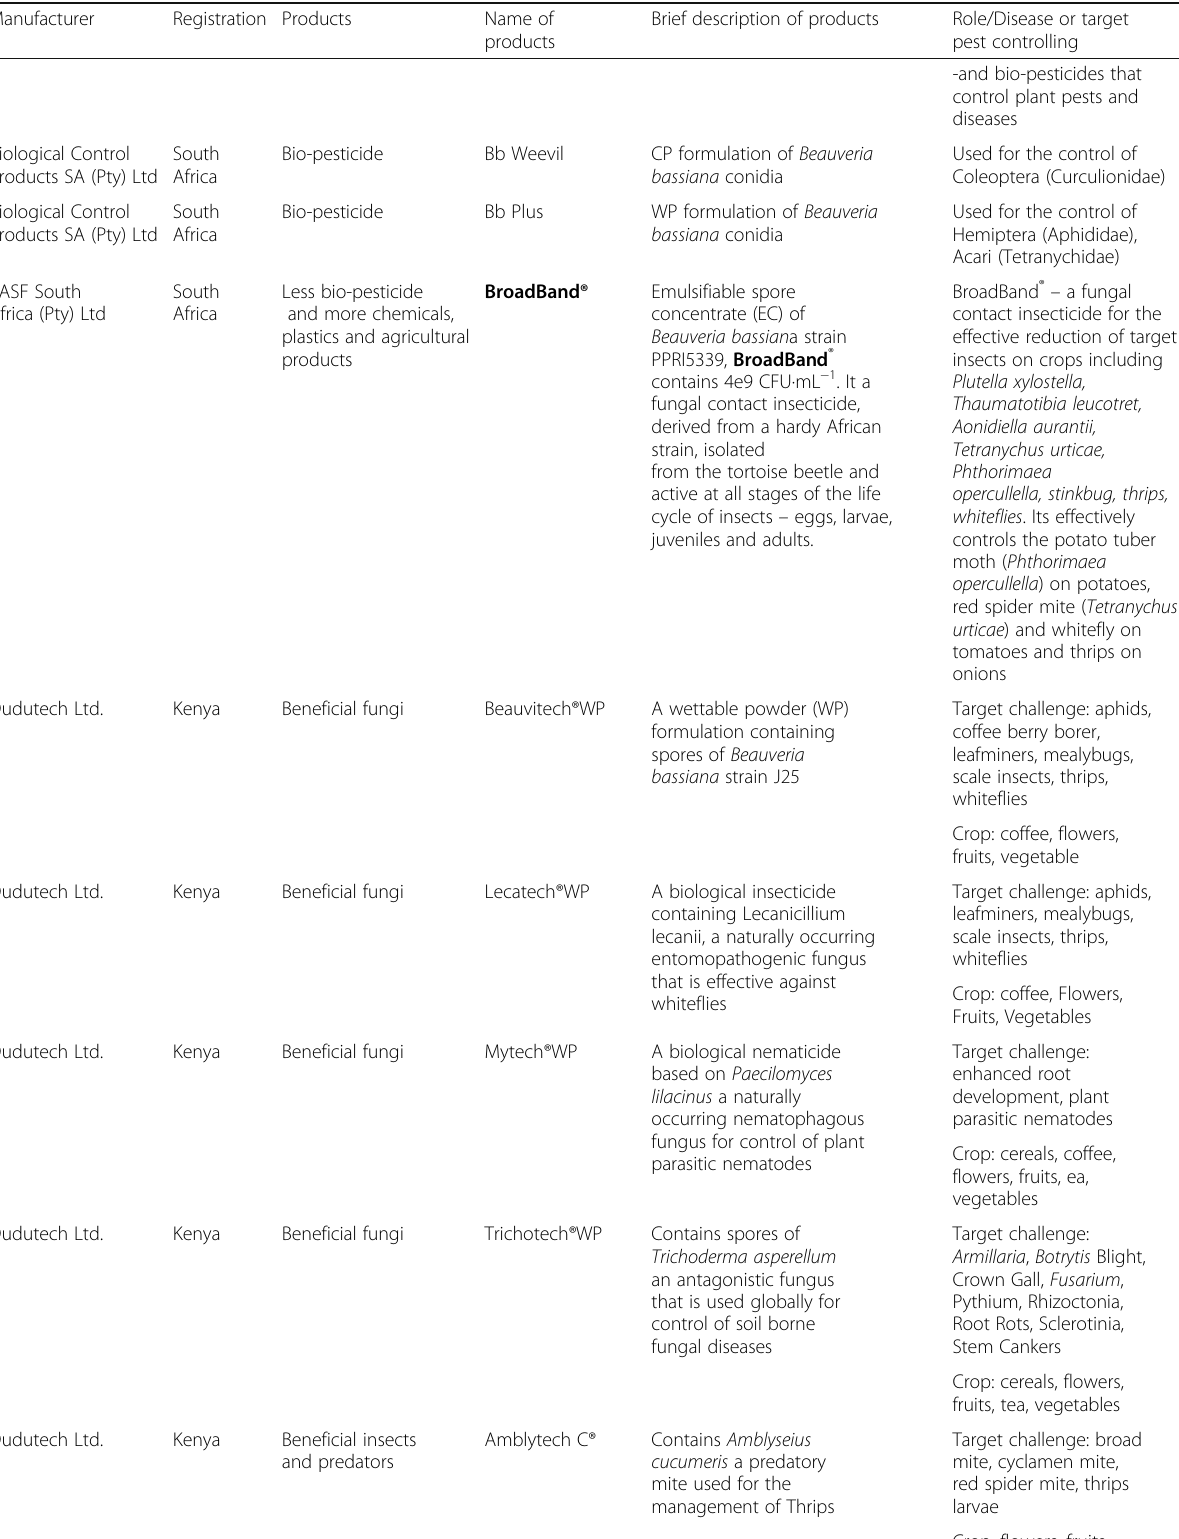
Table 2 Presentation of manufacturers in Africa and commercialized products